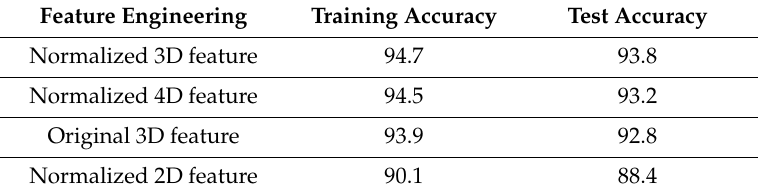
Table 5. Comparison between di ff erent feature engineering